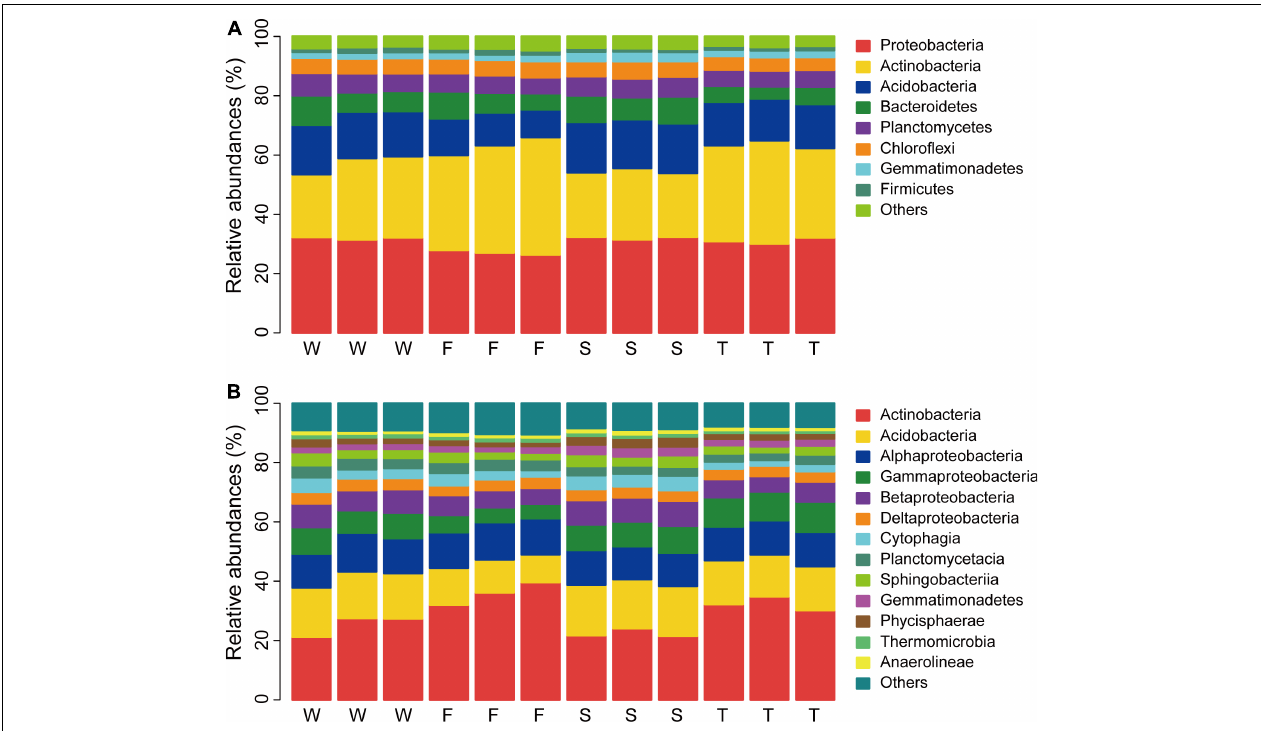
FIGURE 1 | Relative abundances of main soil bacterial phyla (A) and classes (B) . W represents the wheat field; F, S, and T represent the first, second, and third cropping of Jerusalem artichoke (JA),